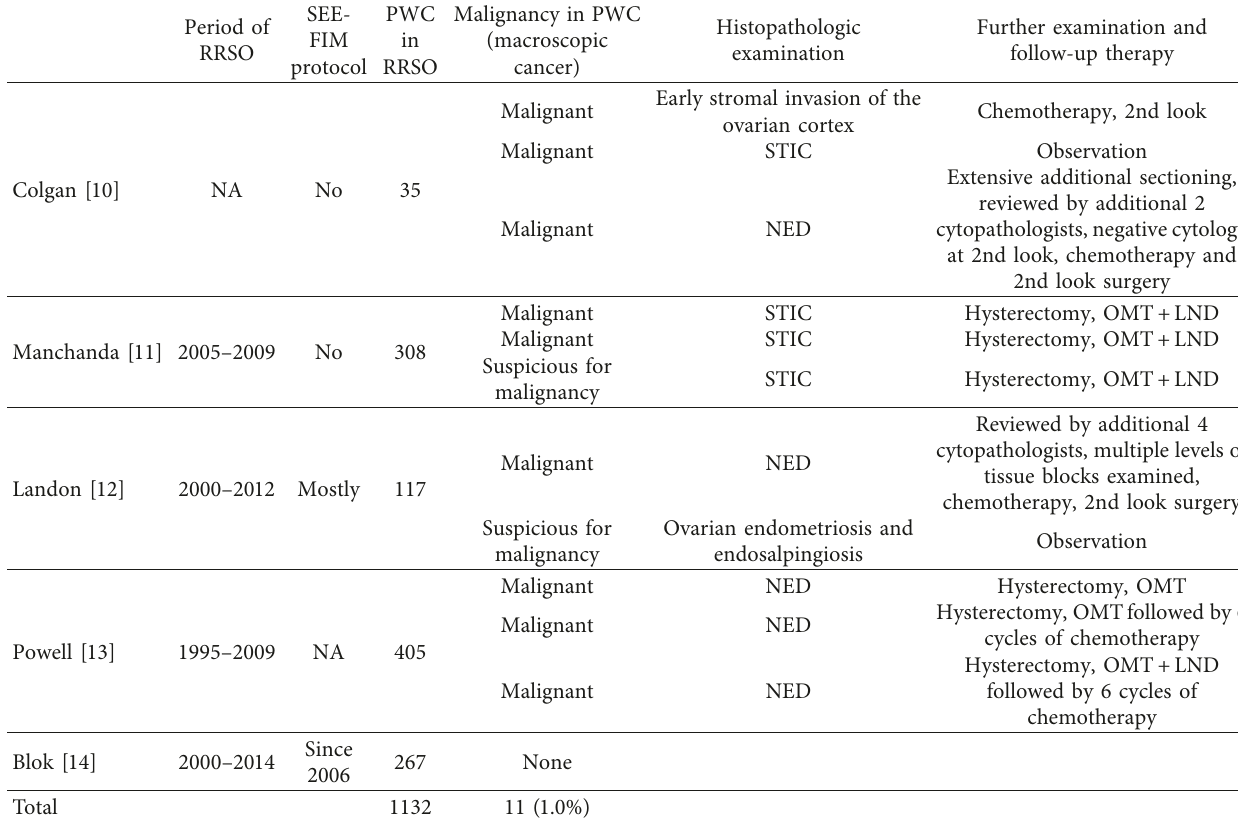
Table 2: “Malignant” or “suspicious for malignancy” on peritoneal washing cytology without macroscopic abnormality. Period